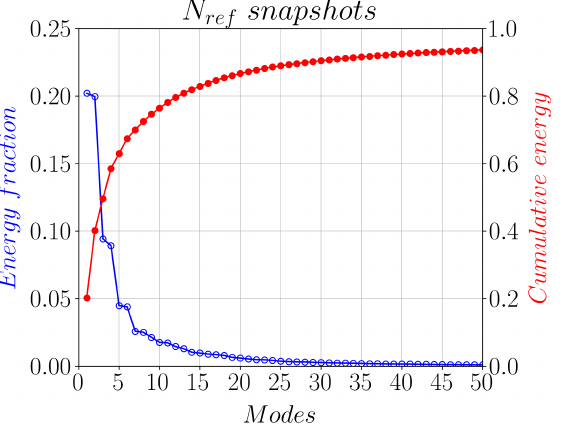
Figure 6. Fraction of the total kinetic energy and cumulative kinetic energies of the POD modes of X t dataset with N ref = 10,000 snapshots.